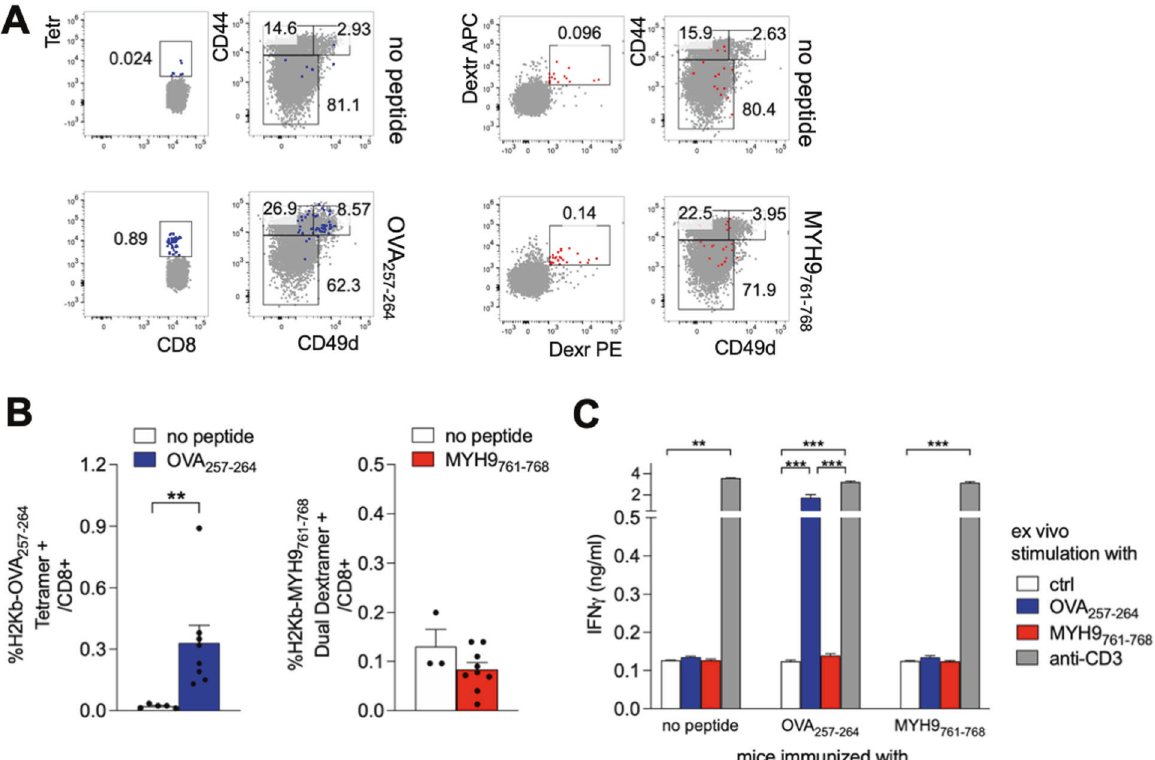
Fig. 5 Immunization with OVA 257-264 , but not with MYH9 761-768 , induces antigen-speci fi c CD8 + T cell responses. C57BL/6 mice were immunized with OVA 257-264 ( n = 8), with MYH9 761-768 ( n = 8) or with no peptide ( n = 5), and fl ow cytometry analysis was performed. Representative stainings ( A ) and percentages ( B ) of OVA 257-264 -speci fi c (blue) or MYH9 761-768 -speci fi c (red) cells in mice immunized with the respective peptides or with saline (no peptide), in alum and MPL as adjuvants. Samples with insuf fi cient numbers of dextramer + or tetramer + events were not included in the analysis. C Splenocytes were challenged ex vivo for 48 h with the indicated stimuli and IFN- γ was measured in the supernatants through ELISA. The data are from a single experiment representative of two independent experiments. Bars represent means ± SEM. ** P < 0.01, *** P < 0.005, by Mann – Whitney